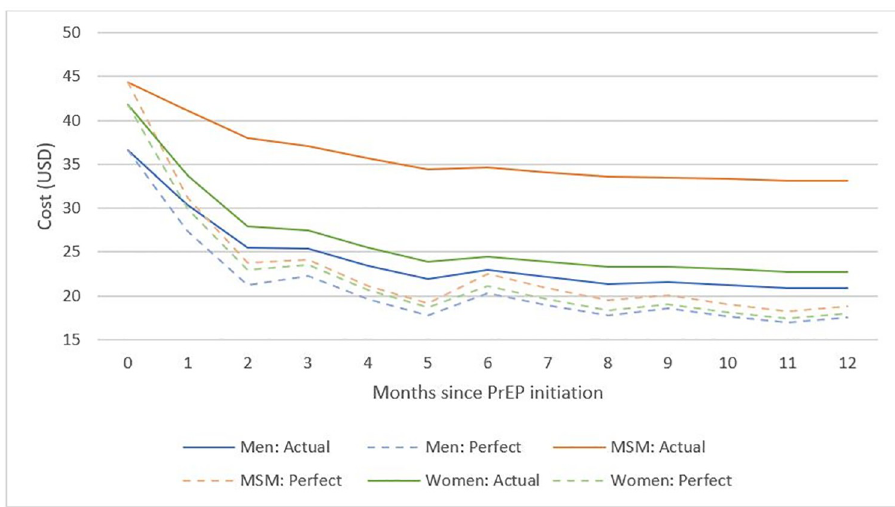
Fig 2. Sensitivity analysis of cost of PrEP provision per person-month effectively covered on PrEP, using aggregate persistence data � . � Persistence was reported for months 1, 3, 6, 9 and 12—for the remainder of the months, and average was taken using the adjacent two data points (i.e. for month 2 persistence, an average was taken of the reported persistence for month l and month 3. Costs are reported in 2021 USD and only include direct service delivery